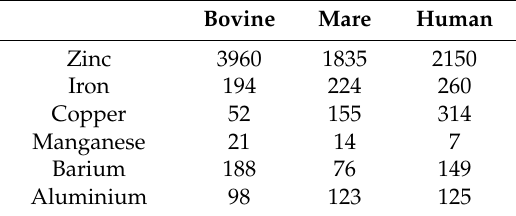
Table 2. Concentration of some trace elements ( µ M) in mare, bovine, and human milk (adapted from [9]). Bovine Mare